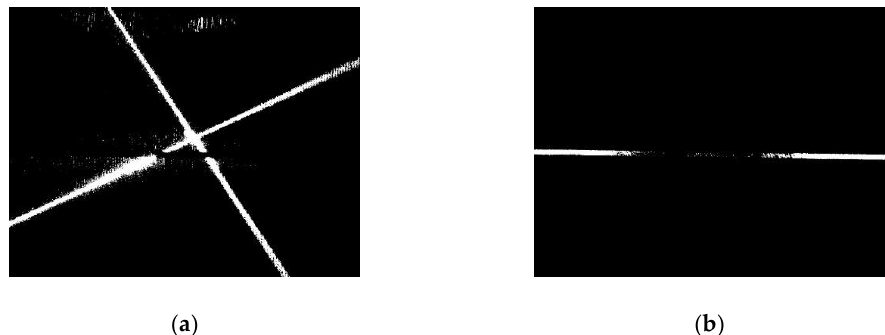
Figure 5. ROI after binarization. ( a ) Laser stripe region. ( b ) Joint region.